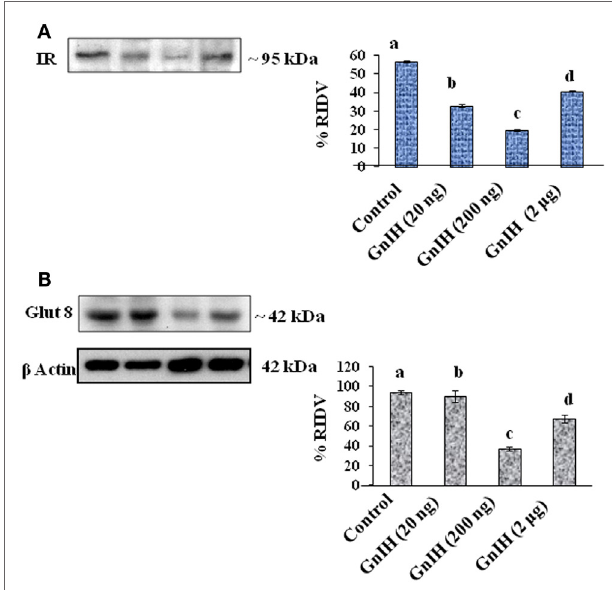
FigUre 3 | The densitometric analysis of the Western blot showed the treatment of different doses (20, 200 ng, and 2 μ g/day) of gnih on expression of ir and glUT8 proteins in testis of mice. (a) The treatment with low and moderate doses (20 and 200 ng/day) of GnIH showed significant (b and c, p < 0.05) decrease in expression of IR protein as compared with the control, whereas high dose (2 μ g/day) caused a significant (d, p < 0.05) increase in the expression of IR protein as compared with the control and moderate dose treatment. (B) The treatment with a low and moderate dose (20 and 200 ng/day) of GnIH showed a significant (b and c, p < 0.05) decrease in the expression of GLUT8 protein as compared with the control, whereas the treatment with a high dose (2 μ g/day) caused a significant (d, p < 0.05) increase in the expression of GLUT8 protein as compared with the moderate dose treatment. Values are mean ± SEM.